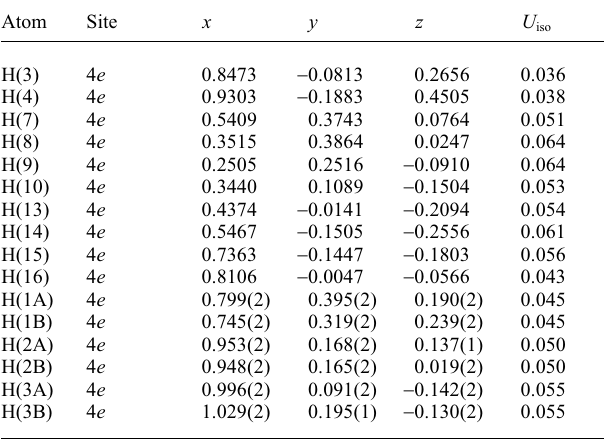
Table 2. Atomic coordinates and displacement parameters (in Å 2 )